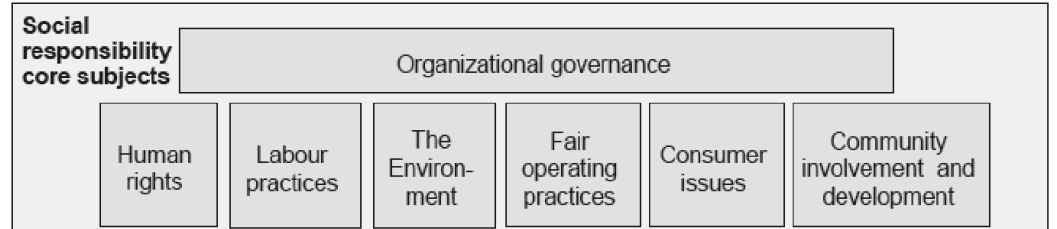
Figure 1. Corporate Social Responsibility Core Subjects according to ISO 26000 [13].